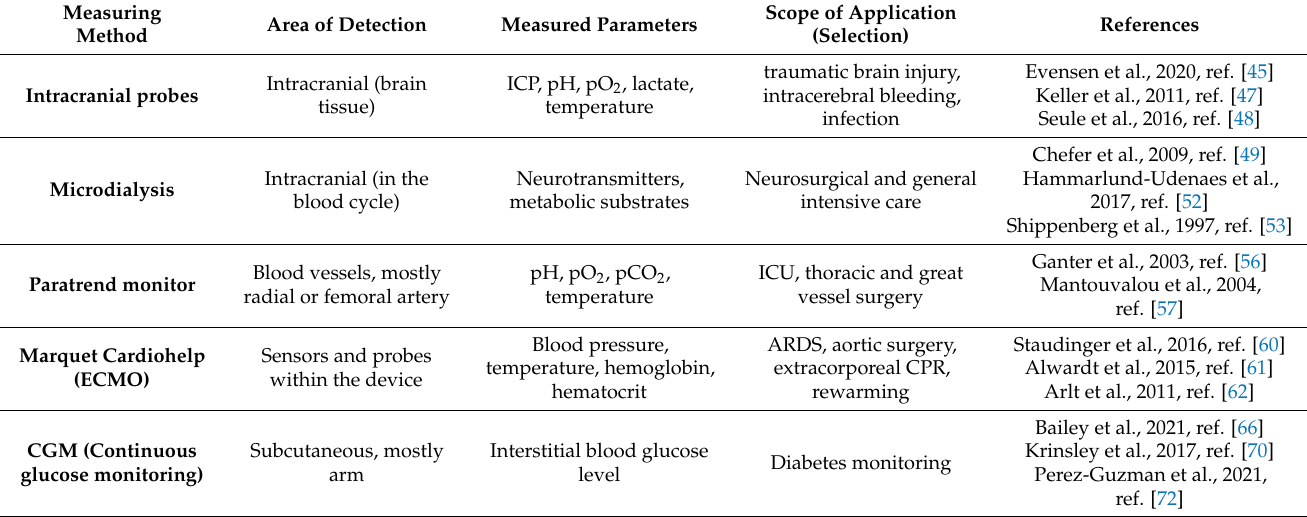
Table 2. Invasive